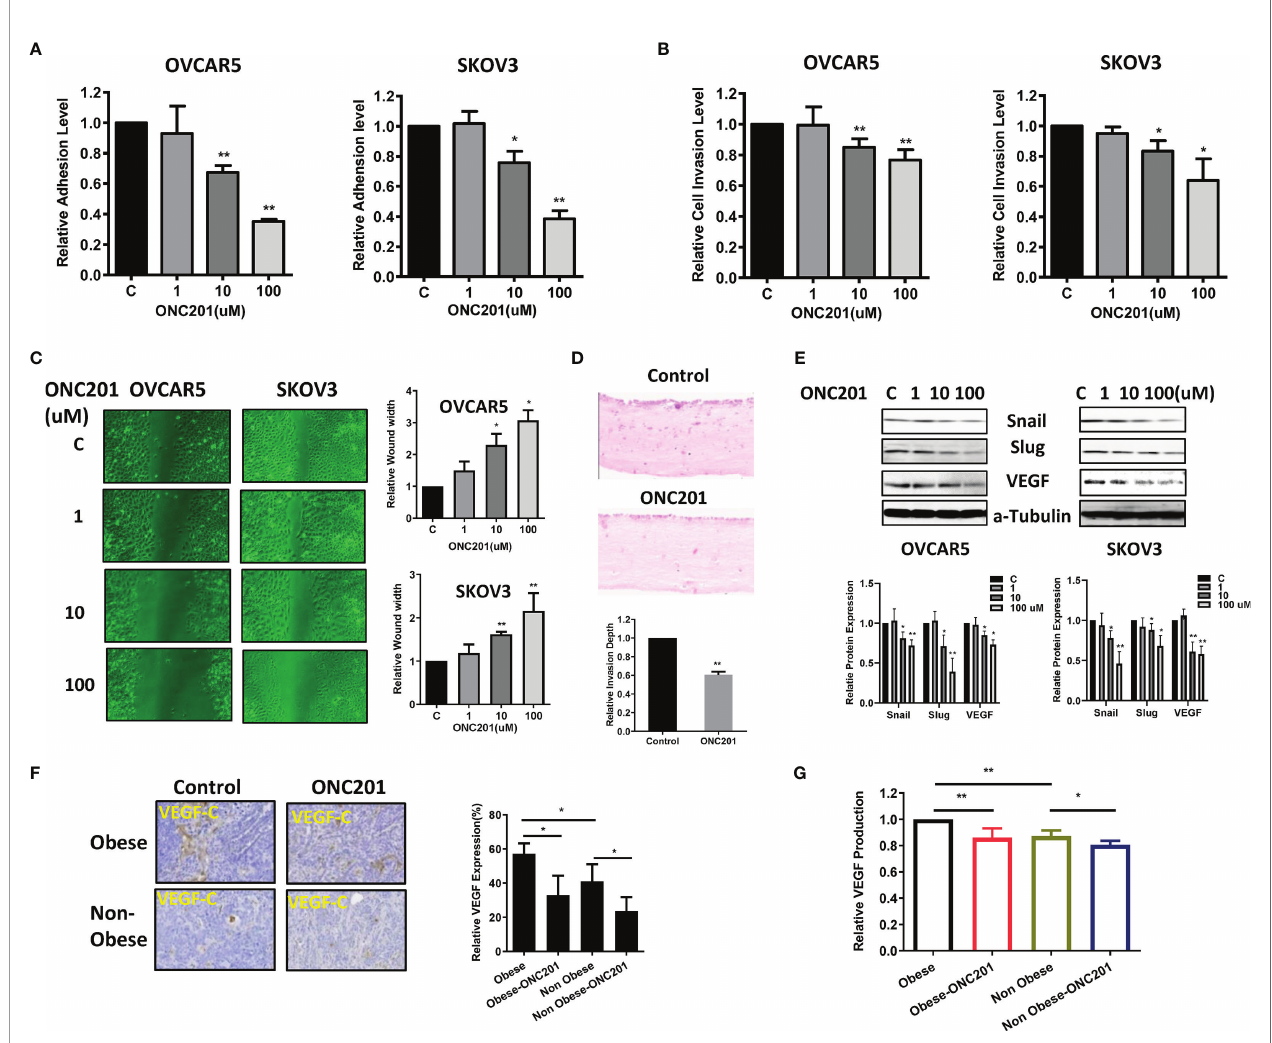
FIGURE 6 | ONC201 inhibited adhesion and invasion. The OVCAR5 and SKOV3 cells were treated with ONC201 at a range of doses from 1 − 100 m M. laminin-1 assay was used to assess adhesion after 2 hour of treatment with ONC201 (A) . Invasion was examined by transwell assay after 4 hours of treatment with ONC201 (B) . Treatment of both cells with 10 and 100 uM ONC201 inhibited cell adhesion and invasion. Migration was assessed by wound healing assay after treatment with ONC201 for 48 hours. ONC201 (10 and 100 uM) signi fi cantly reduced cell migration in both cell lines (C) . Organotypic 3D co-culture using OVCAR5 cells with and without ONC201 (10 uM) was carried out and the relative invasion depth calculated. ONC201 decreased the invasion index in OVCAR5 cells (D) . Western blotting found that ONC201 reduced the expression of VEGF, Snail and Slug in both cell lines (E) . The obese and lean KpB mice were treated with ONC201 for 4 weeks. IHC results showed that ONC201 reduced VEGF expression in both obese and lean mice (F) . Obesity was associated with increased serum VEGF production as compared to lean mice, and ONC201 reduced the production of VEGF in serum under obese and lean conditions (G) . * <0.05, **